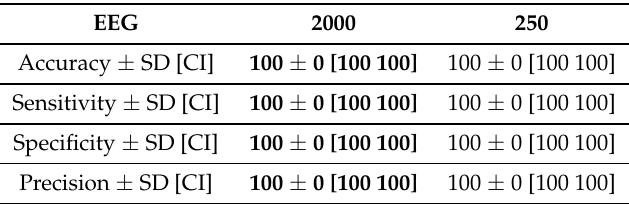
Table 9. Accuracy, Sensitivity, Specificity and Precision for the Performance of 250 and 2000 Bootstrap Resampling Using LSTM ECOC-SVM with Pre-processed EEG. (The Numbers in Bold Indicate the Best Value Obtained for Each Quality Measure).